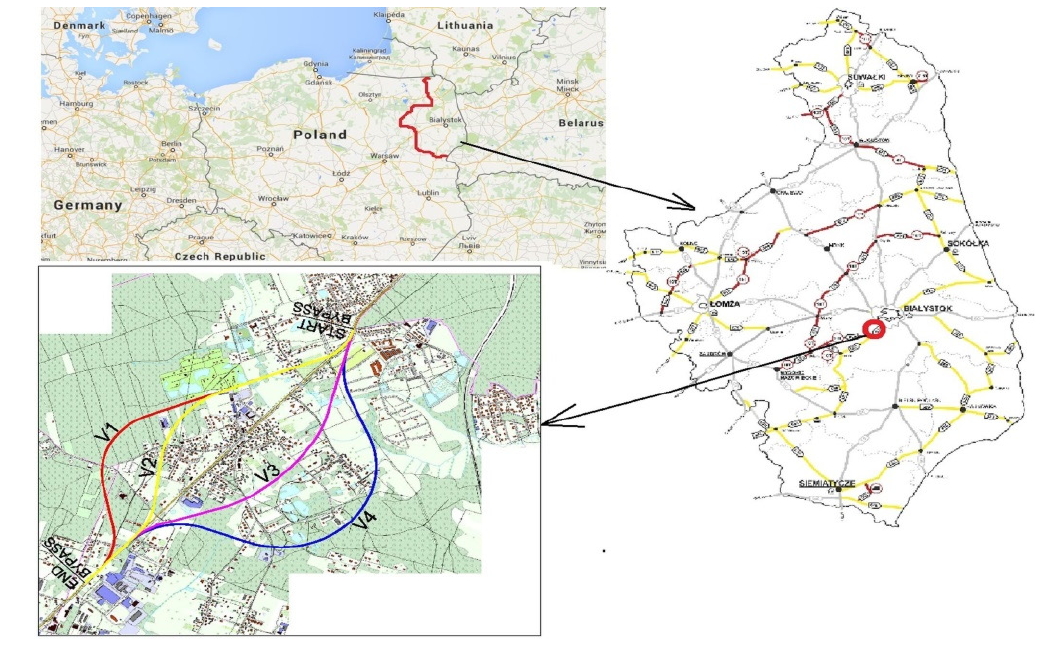
Fig. 1. The variants of bypass alignment for the town of